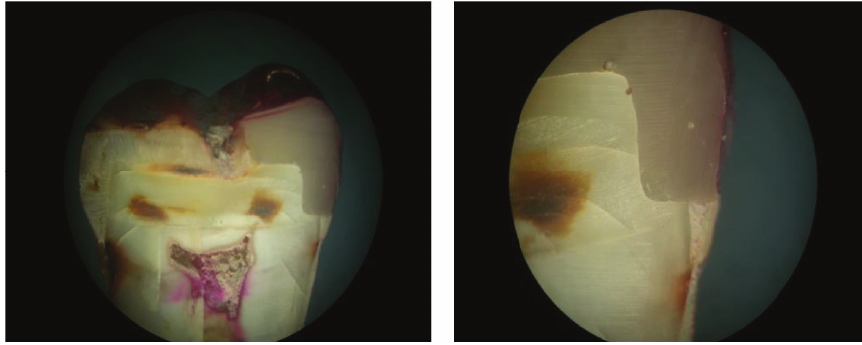
Figure 5: Group 2: microleakage seen under composite restorations with flowable composite liner, precure group.